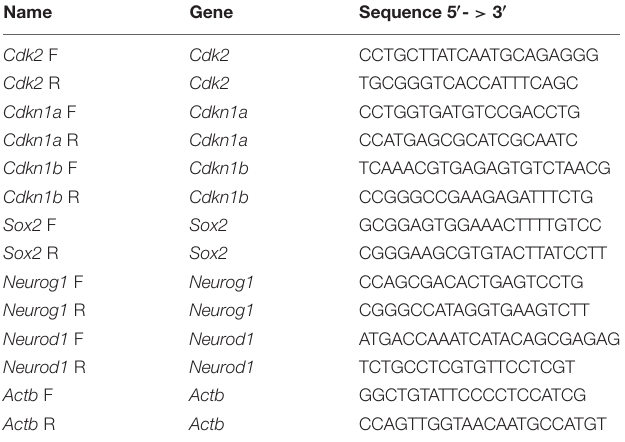
TABLE 1 | Primers for qPCR.